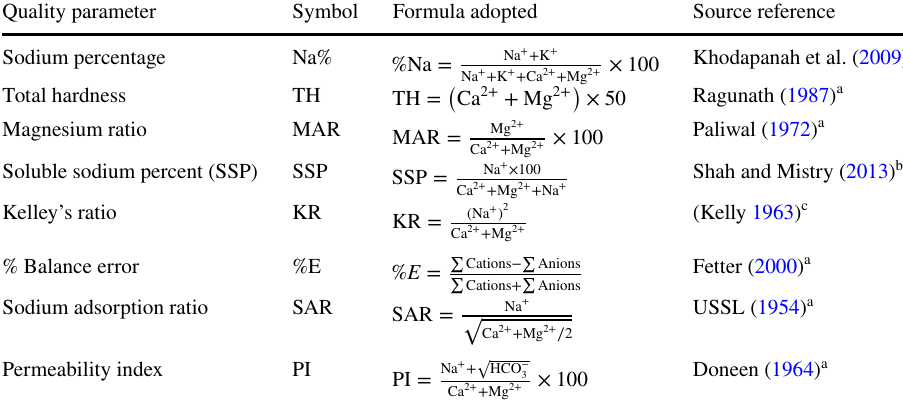
Table 3 Evaluated water quality parameters’ estimation